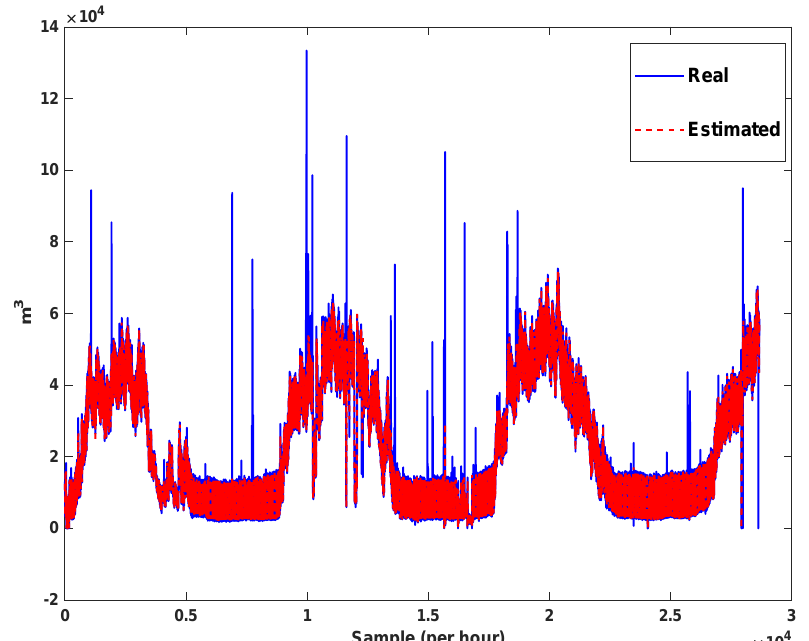
Figure 11. Modeling peak of consumption in per hour.